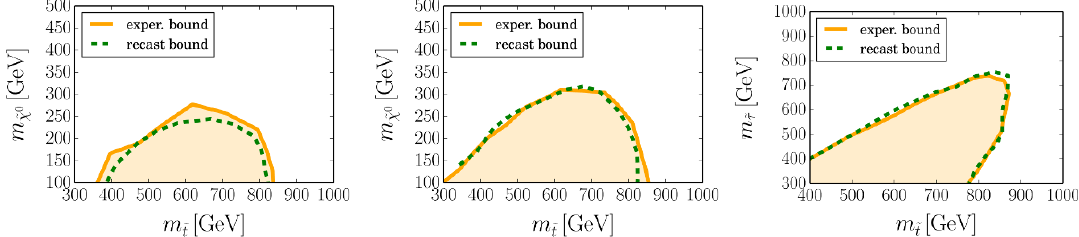
Figure 7 . Comparison of the bounds reported by the experimental papers (solid orange lines) of ref. [39] (left panel), ref. [40] (middle panel) and ref. [41] (right panel) with those obtained after recasting the analyses (dashed green